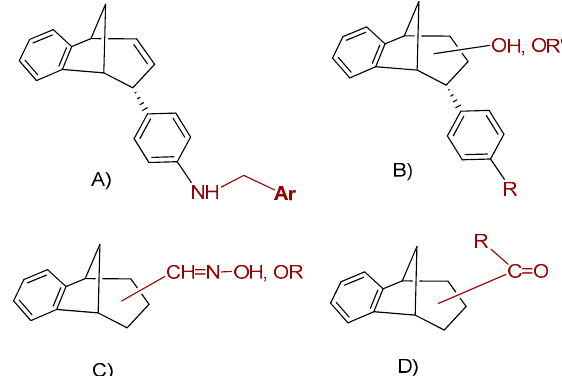
Figure 2. Functionalization of the benzobicyclo[3.2.1]octadiene skeleton employed in this study: ( A ) amines; ( B ) epoxides, alcohols and ethers; ( C ) oximes and oxime ethers; and ( D ) acyl derivatives.